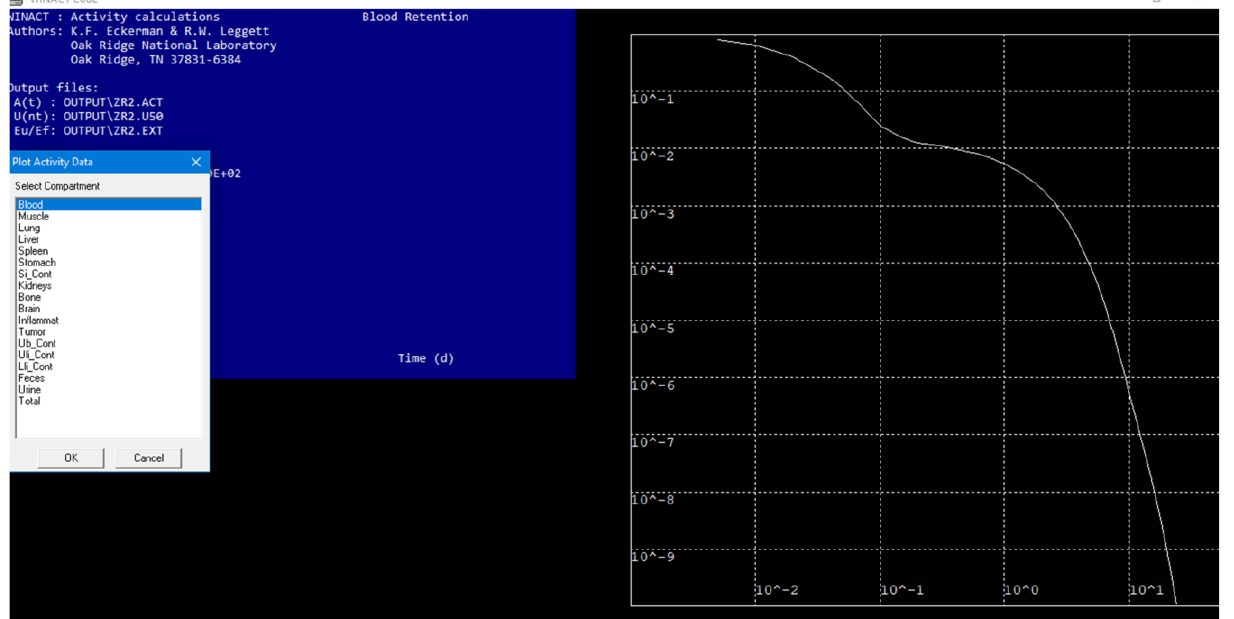
Figure 3. WinAct Running.